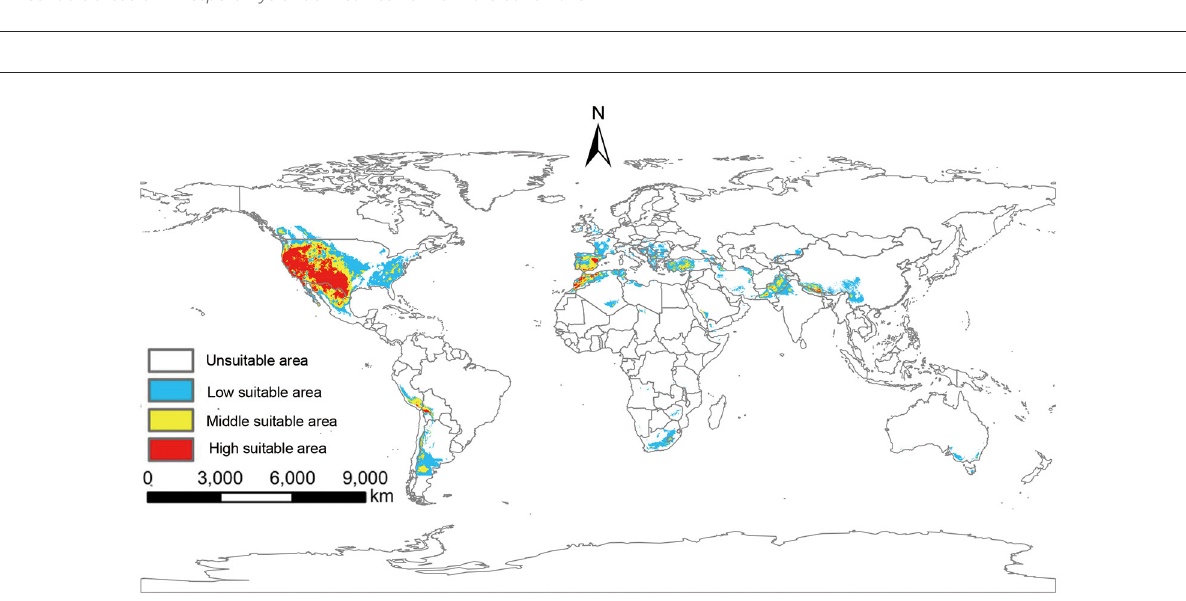
FIGURE4 Suitable areas of O. sexdentatus under near-current climate